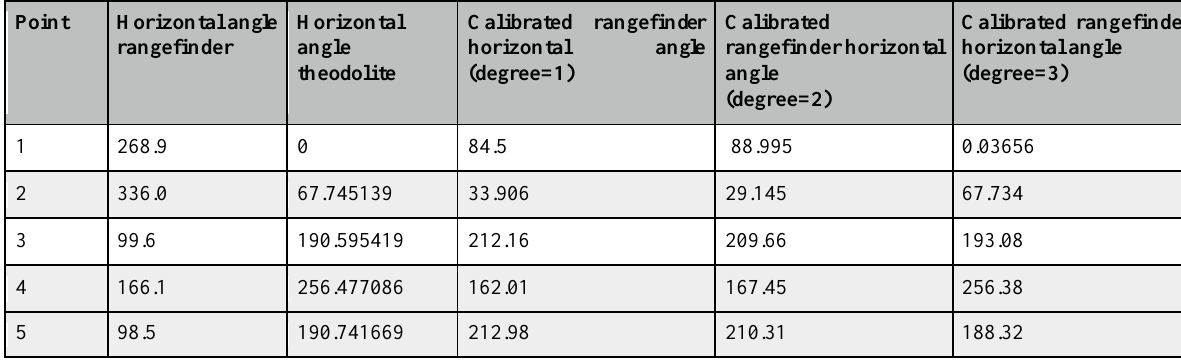
Table 4: Calibration of room 1 rangefinder horizontal angle measurements using total station horizontal angle measurements by polynomial kernels. Point Horizontal angle rangefinder